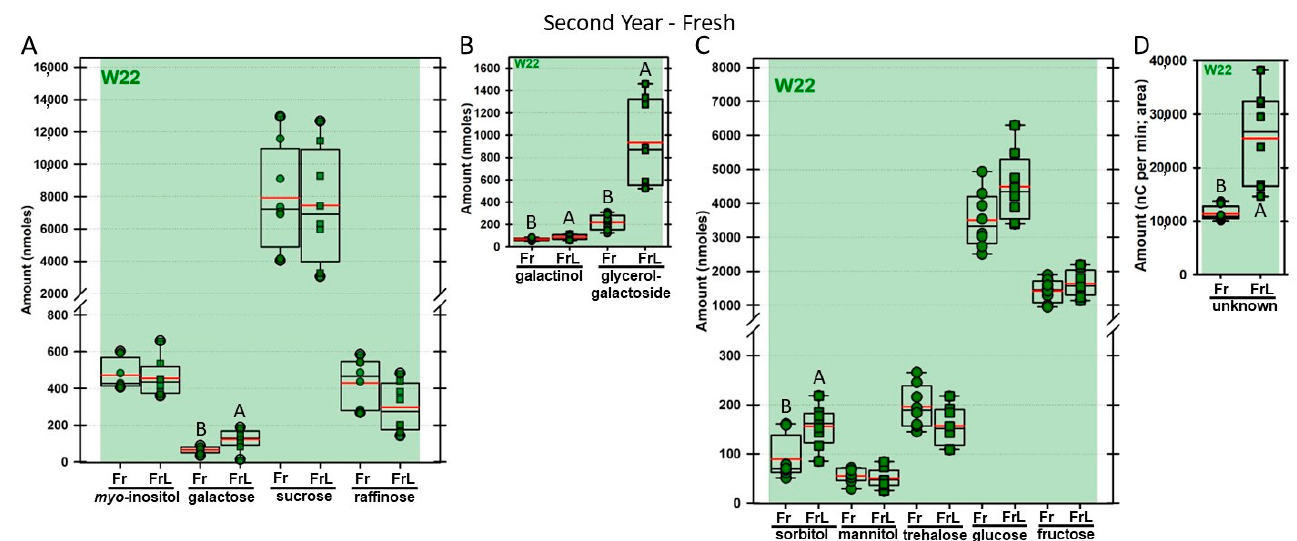
Figure 11. Carbohydrates were analyzed from W22 wild type (W22) maize leaves. The disks were ground immediately upon harvest (Fr = fresh; dark green circles) or were lyophilized to dryness without prior exposure to LN 2 (FrL = fresh lyophilized; dark green squares). The same carbohydrates are depicted, and statistically significant differences are determined in the same manner, as in Figure 4.